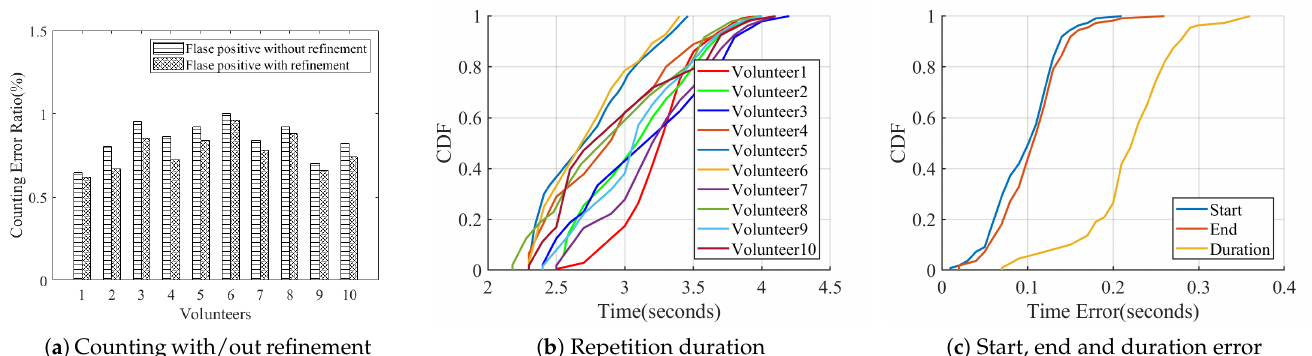
Figure 19. Segmentation results